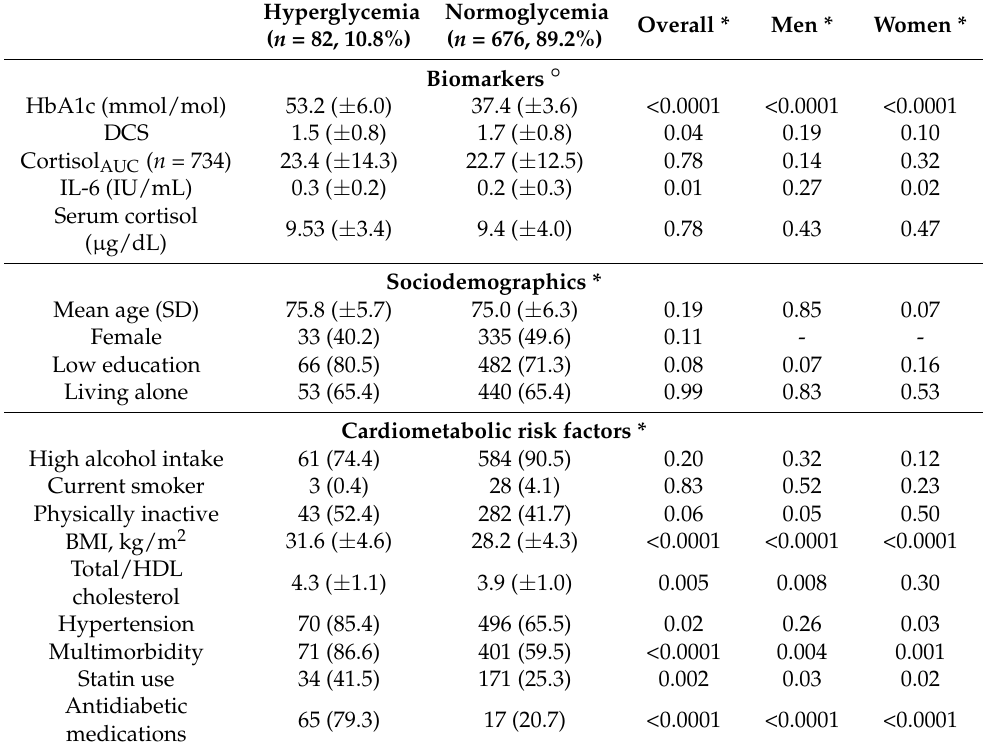
Characteristics of the KORA Age study population stratified by glycemia status (HbA1c ≥ 6.5% vs. HbA1c < 6.5%) in means ( ± SD) or N (%) ( n = 758). Hyperglycemia ( n = 82, 10.8%)